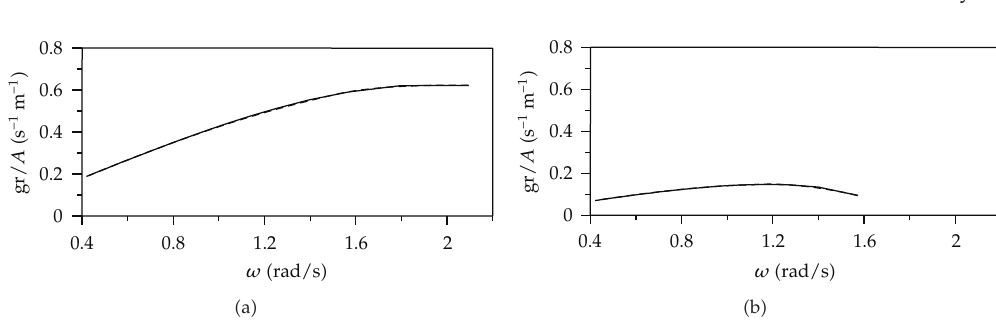
Figure 5: Theoretical determined internal wave growth rates as functions of surface wave frequency ω , H (cid:8) 4m, γ (cid:4) (cid:8) γ (cid:4)(cid:4) (cid:8) 0 . 83, (cid:4) a (cid:5) h (cid:4) (cid:8) 0 . 1m, and (cid:4) b (cid:5) h (cid:8) 0 . 3m.